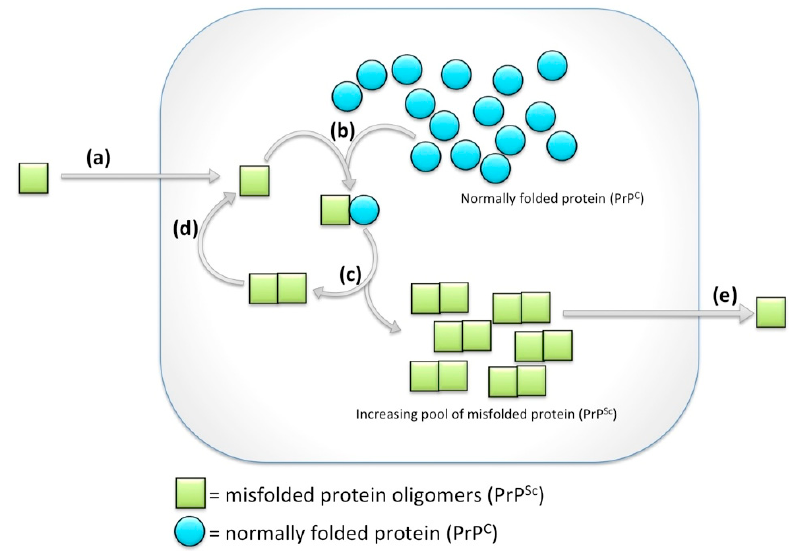
Figure 1. A highly simplified schematic of template directed misfolding in prion-like diseases. Temporal events that make up a cycle of template-directed misfolding: ( a ) A molecule (or oligomer or aggregate) of misfolded prion (PrP Sc , represented by green square) arrives to a naïve tissue or cell. This spreading to new locations initiates proteostatic disruption and degenerative events in otherwise healthy cells; ( b ) Normally folded prion protein (PrP C , i.e., “cellular” form represented by blue circles) is recruited to interact with PrP Sc ; ( c ) Thus PrP Sc accumulates in the new cell, with two consequences; ( d ) The PrP Sc fragments (e.g., oligomers or fibrils) break apart and recruit more PrP C into the misfolding cycle; ( e ) PrP Sc continues to spread to new cells and tissues. All the events in this model represent functions gained upon protein misfolding, whereas our synthesis asks if disease etiology ought to also consider functions that are lost following protein misfolding.